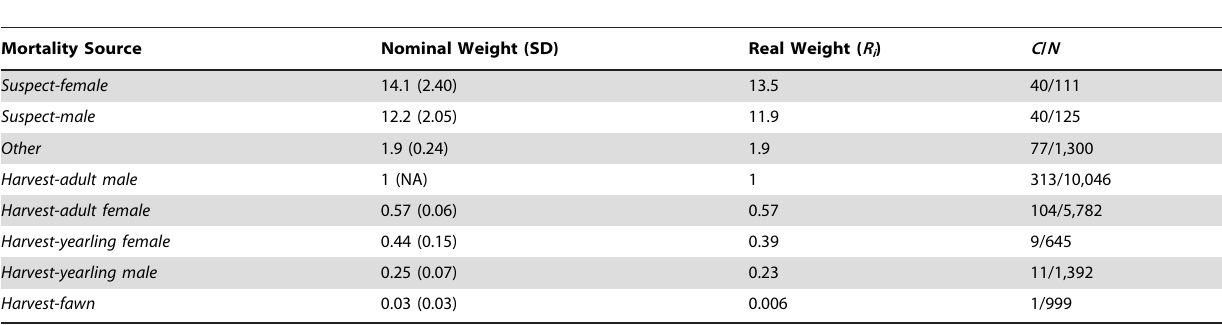
Table 2. Nominal and real surveillance weights calculated using data from